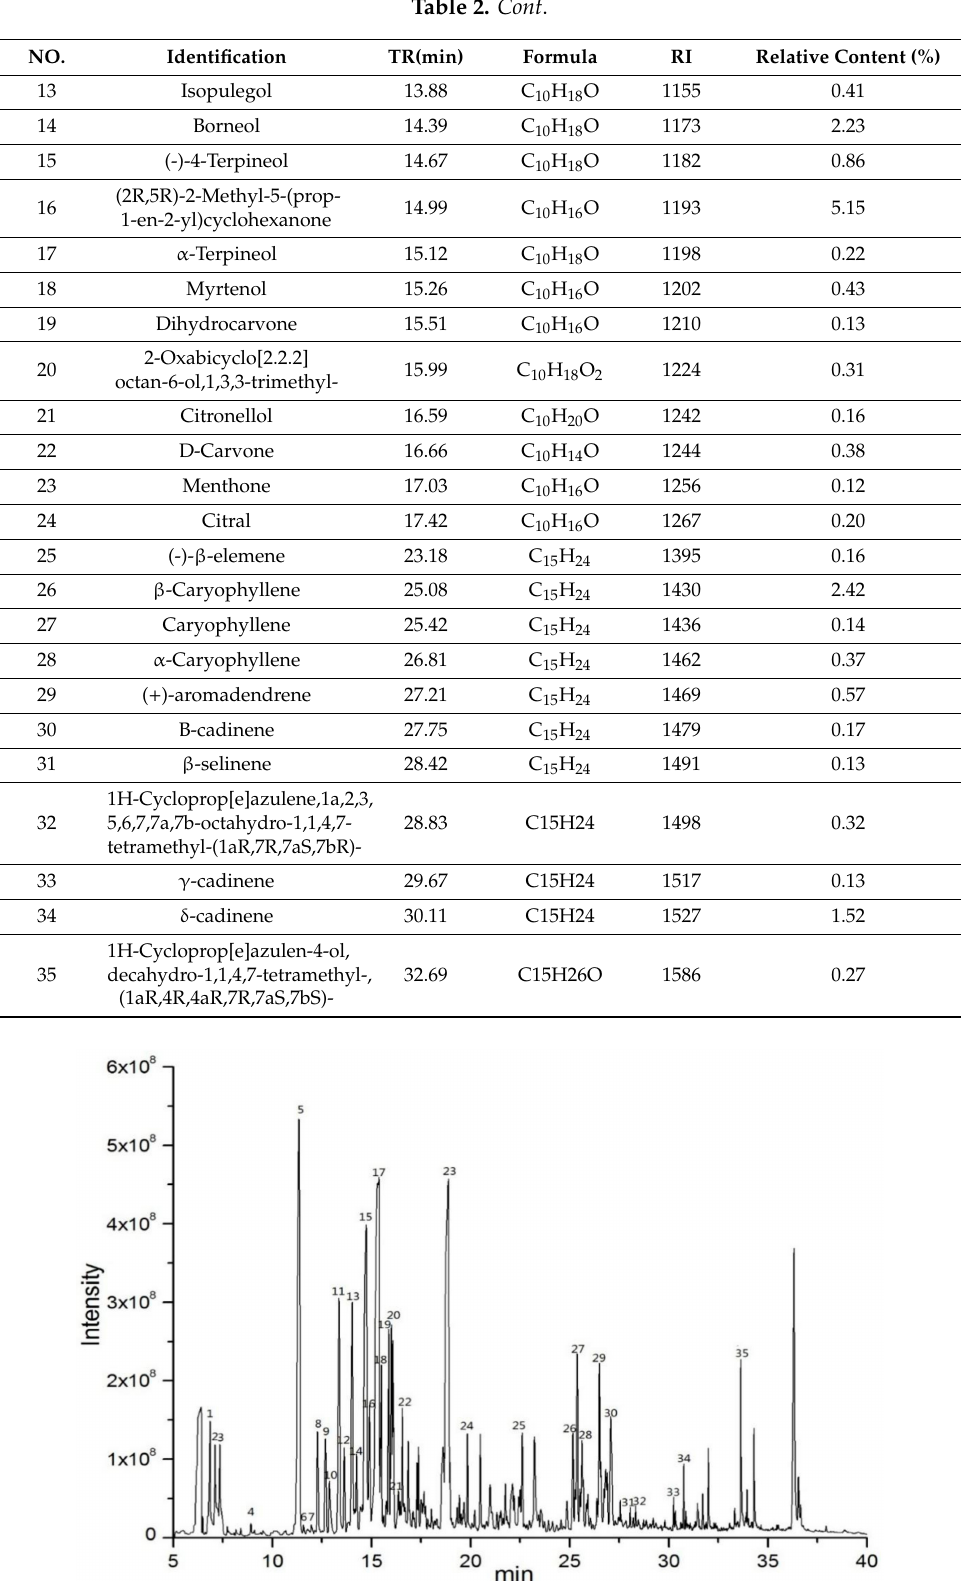
Figure2. Totalionchromatogramofvolatilecompoundsfromthe E.globulus